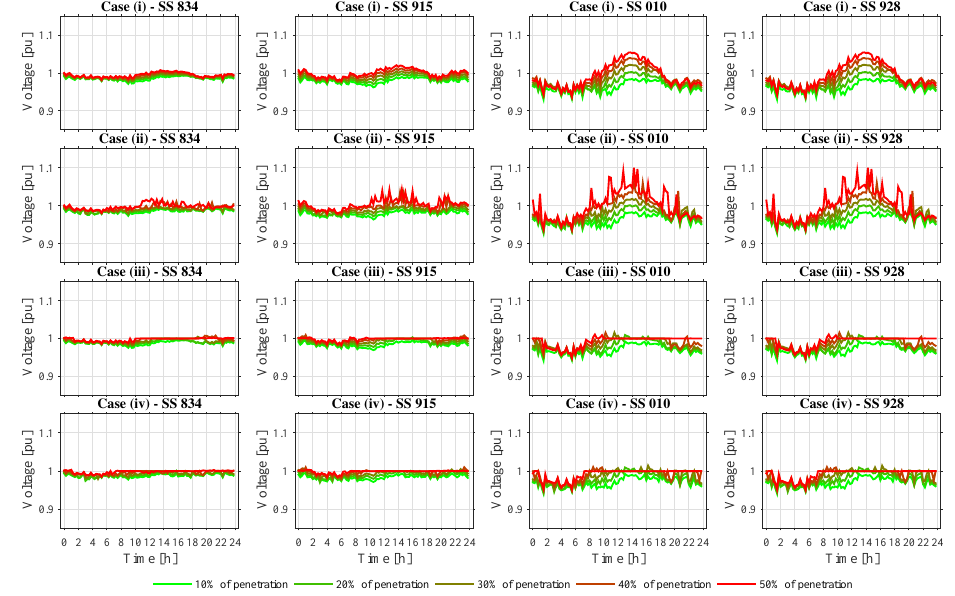
Figure 7. Voltage at SS 834, SS 915, SS 010 , SS 928 for each case (rows) and for all DG penetrations (colour